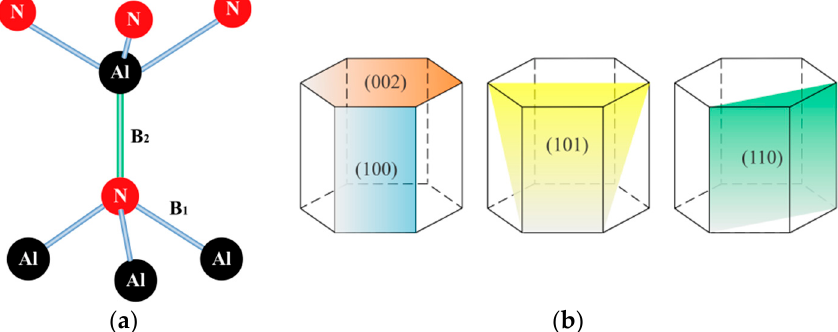
Figure 8. ( a ) Al–N bonds formed distorted tetrahedron and ( b ) geometry of crystallographic planes for (100), (002), (101) and (110) in hexagonal AlN lattice. (After Reference [34]).